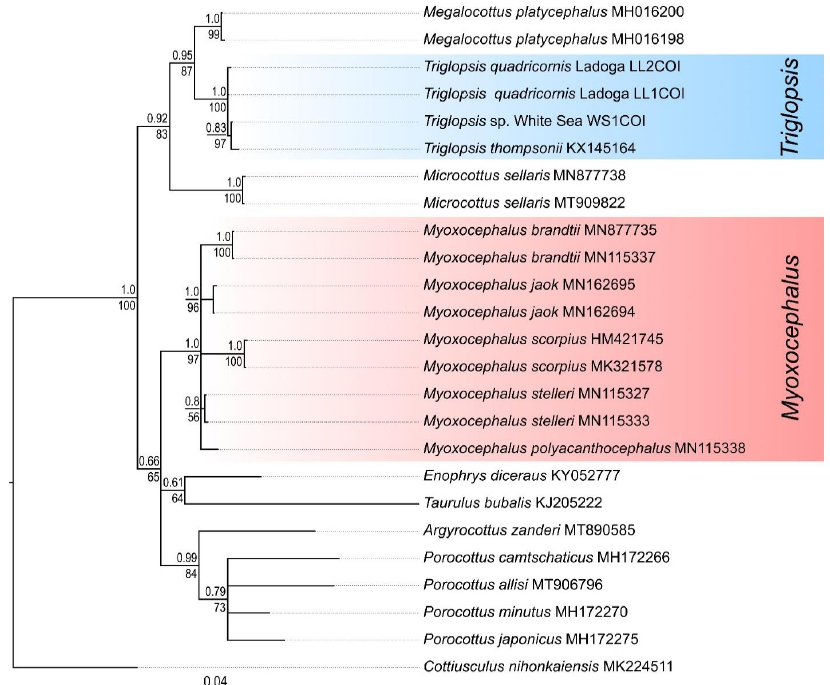
Figure 7. Bayesian phylogenetic tree of marine representatives of the subfamily Myoxocephalinae reconstructed using the sequences of the mtDNA COI . For each node, the posterior probabilities (upper number) and the bootstrap values obtained in the ML analysis (lower number) are indicated. The clades corresponding to the two genera were also well isolated from each other and had very high supports on the COI tree (Figure 7). The subclades corresponding to T. quadricornis and the White Sea Triglopsis sp. were not separated with in the “ Triglopsis ” clade. The topology of the COI tree differs from that of the CR . The differences are related to the mutual arrangement of various genera, as well as the presence of many nodes with polytomy. This marker accumulates insufficient substitutions to study recent divergences.